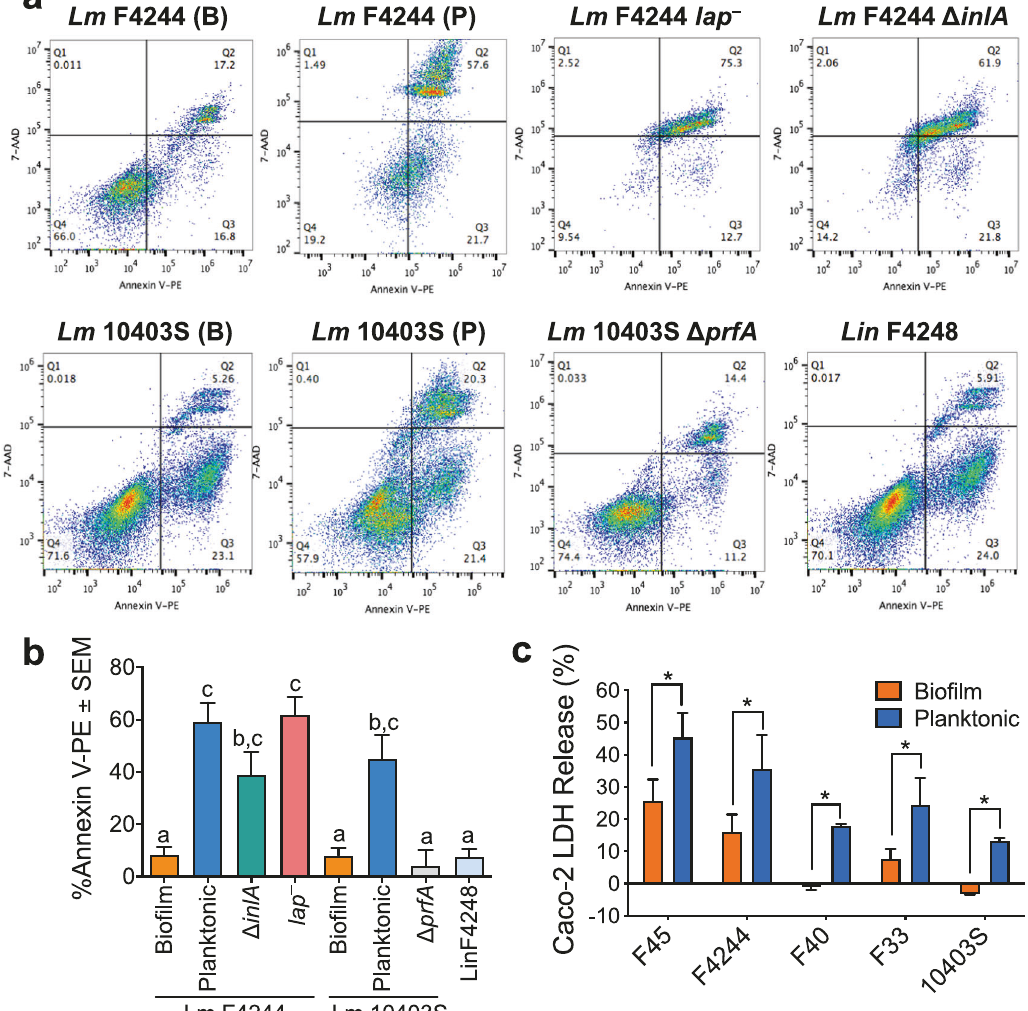
Fig. 3 Cytotoxicity assessment of bio fi lm-forming sessile and planktonic L. monocytogenes . a Flow cytometric analysis of Ped-2E9 (B cell hybridoma) cells treated with bio fi lm-isolated (B) and planktonic (P) cells of L. monocytogenes ( Lm) F4244 and 10403S and corresponding mutant strains at MOI 10. Annexin V-PE-positive and 7-AAD-negative events (Q3) were identi fi ed as cells in the early phase of apoptosis. Events with both Annexin V-PE and 7-AAD positive (Q2) or both negative (Q4) were identi fi ed as dead or live cells, respectively. L. innocua ( Lin ) F4248 was also tested as a nonpathogenic negative control. b Quantitative comparison of overall damage of Ped-2E9 caused by bacteria. Each bar represents the percentage of Annexin V-PE-positive events, which included early apoptosis (Q3) or dead (Q2) cells. Bio fi lm-isolated bacteria of both strains were signi fi cantly less cytotoxic than their planktonic counterparts. Bars marked with different letters are signi fi cantly different at P < 0.05. c Lactate dehydrogenase (LDH) released from Caco-2 cells (a colorectal adenocarcinoma) treated with both sessile or planktonic cells. Bacteria were incubated with cells at MOI 10 at 37 °C for 2 h. Data are the average of at least three independent experiments performed in triplicate. All error bars represent SEM. A pairwise Student ’ s t -test was used for statistical analysis. * P <